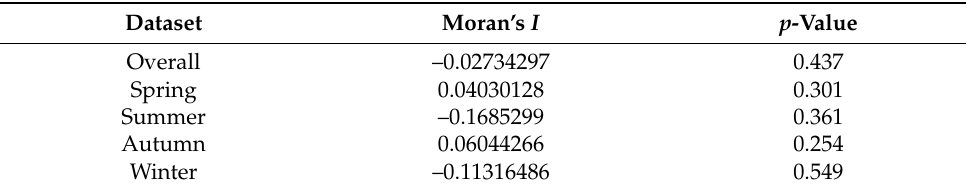
Table 5. Global spatial autocorrelation (presented as Moran’s I statistics) of overall and season analyses for RRV seropositivity in QLD.